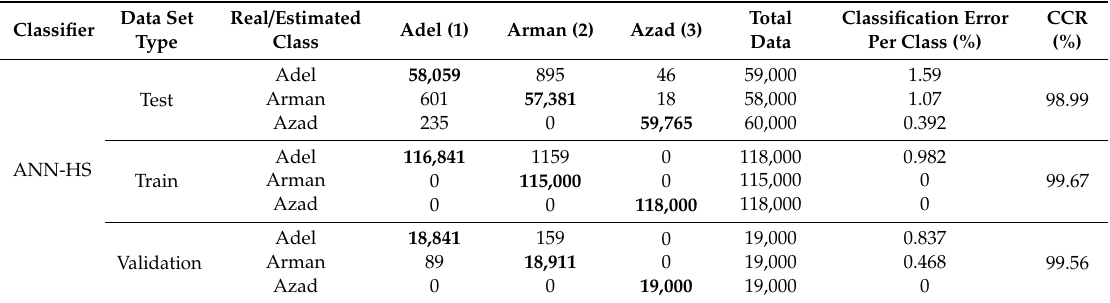
Table 7. Confusion matrix including correct classification rate (CCR) for ANN-HS classifier: Adel, Arman and Azad chickpea ( Cicer arietinum L.) varieties (1000 uniform random iterations, test train and validation sets).